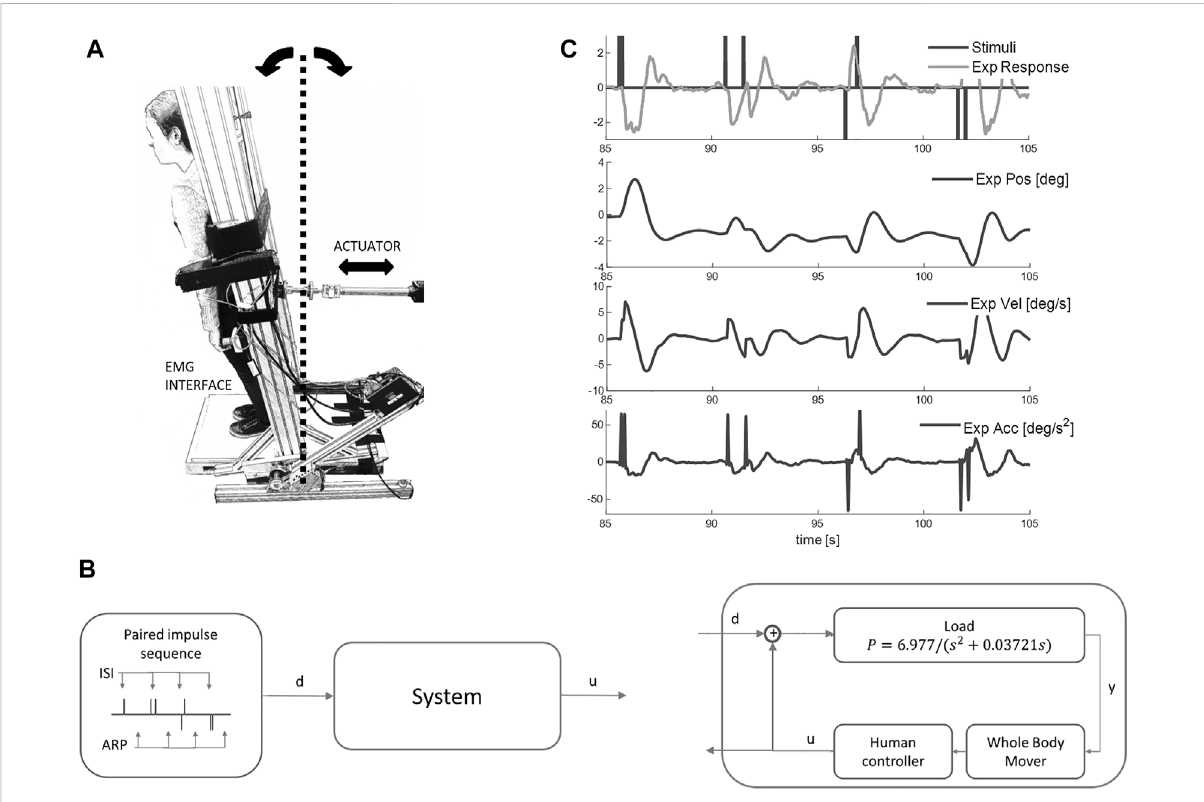
Balance task and response to impulse perturbations. (A) Participants, strapped to a one degree of freedom device with second order dynamics of upright standing, used visual-haptic-vestibular feedback and myoelectric control signals from the calf and tibialis anterior muscles to maintain balancefor250s.Inthisstudythesecondorderdynamicsweresettobemarginallystable:thesesettingensuredclosedloopswayresemblednatural postural sway most closely. (B) An input disturbance of discrete impulses (d) was applied and participants were asked to maintain balance (ISI: inter-stimuli interval between impulses; ARP: approximate recovery period; d: disturbance; y: load position; u: myoelectric control signal). (C) Representative disturbance (black upper), control signal (grey, upper), board angle, board velocity and board acceleration v time (s). Net myoelectric control signal responds to the discrete